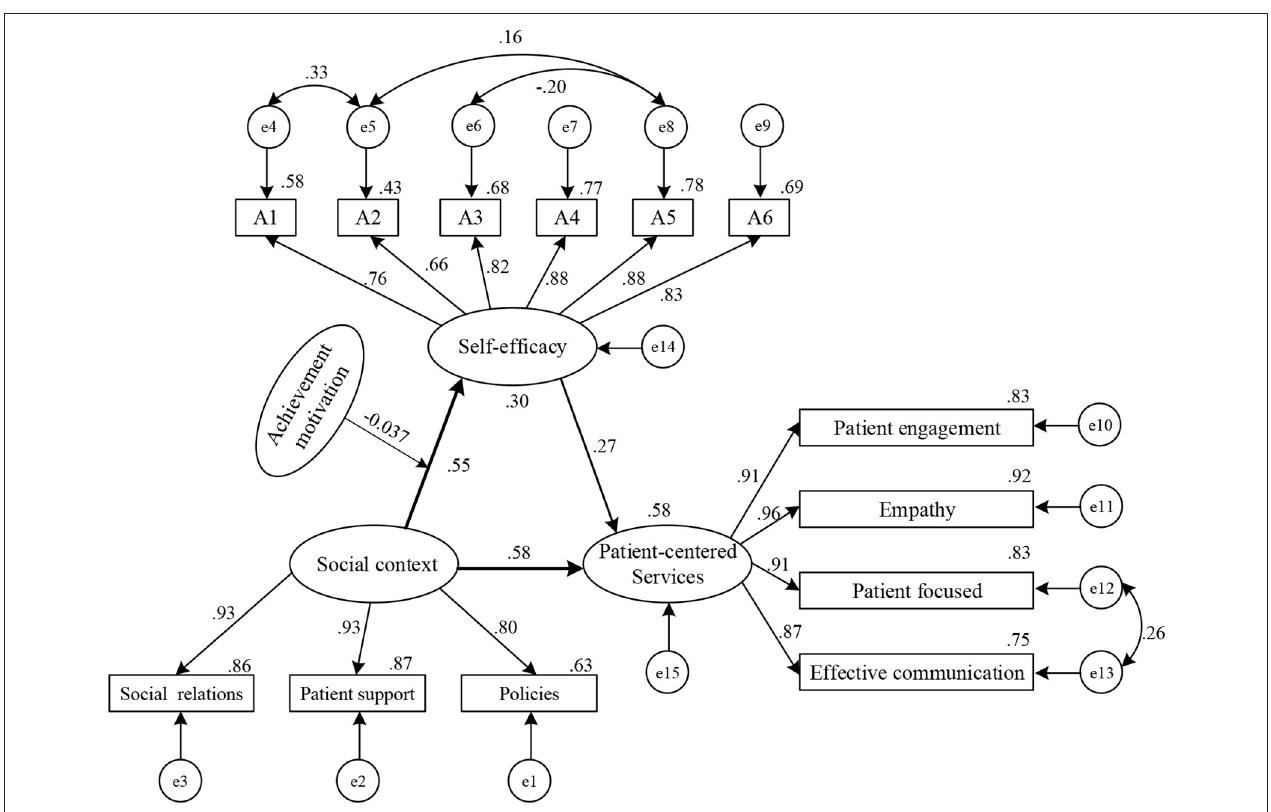
FIGURE 2 | Model diagram of driving mechanism of medical professionals’ patient-centered service behavior.